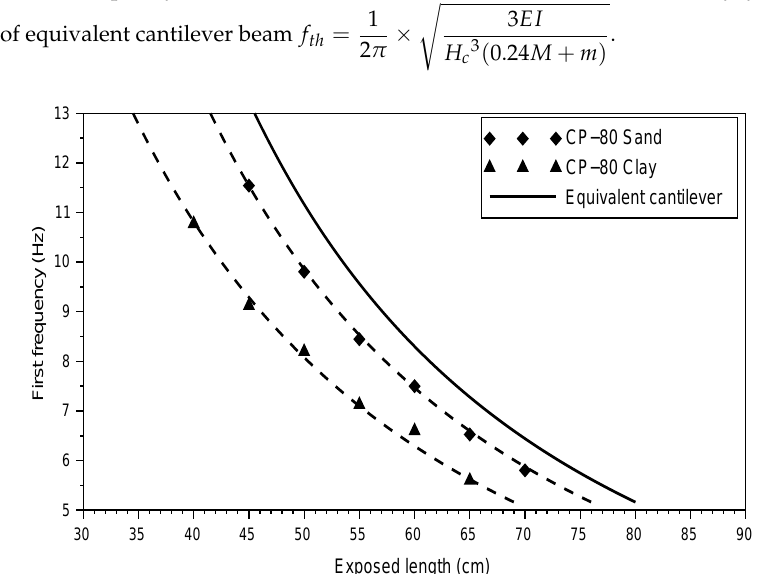
(cid:115) 1 3 EI × . 2 π H c 3 ( 0.24 M + m )